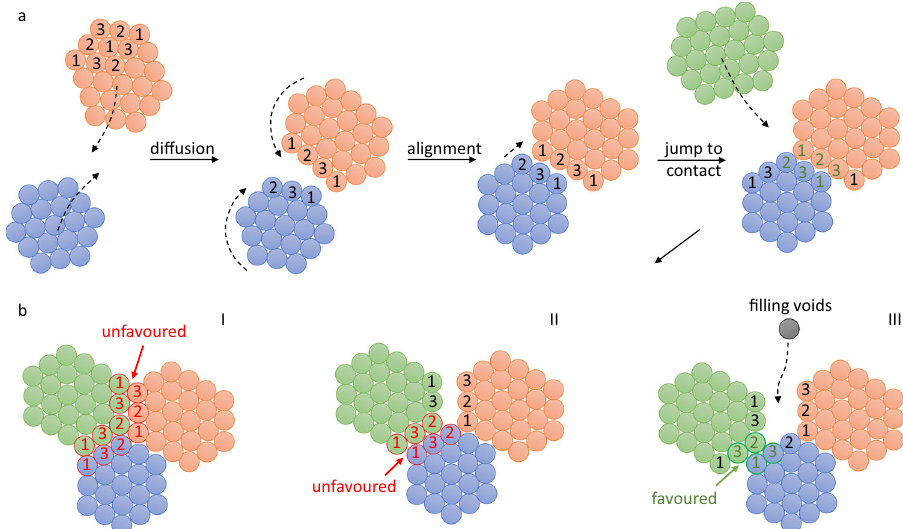
Fig. 4 Model for OA of GI nanocrystals. GI molecules pack along a 3-fold axis within the (001) plane in which we discern three different GI orientations (1,2,3). Nearest neighbors exclude GI molecules with identical orientations; a Simpli fi ed scheme of self-assembly: freely diffusing nanocrystals approach each other, followed by rotational and translational adjustments to align both lattices. Alignment facilitates a fi nal jump to contact by desolvation of the surface patches that partake in lattice contact formation; b Illustration of three different scenarios for further growth: I and II violate H32 symmetry rules and are likely to lead to the formation of a GB at the interface; III leads to successful merger of all three lattices and the resulting voids can be fi lled by monomer